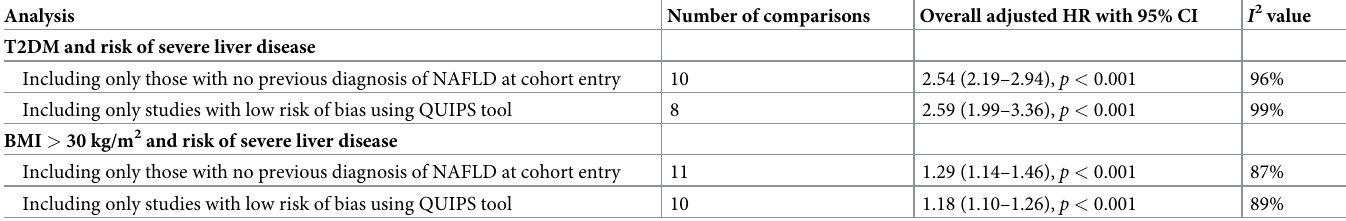
Table 2. Risk of fatal and/or non-fatal severe liver disease events associated with T2DM and obesity: Sensitivity